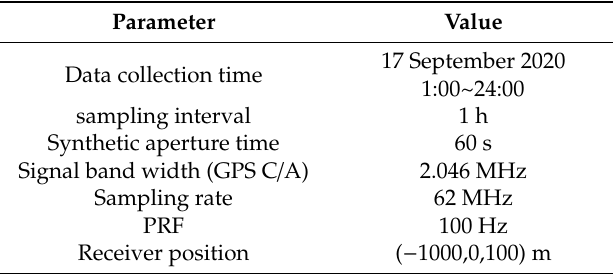
Table 3. Simulation